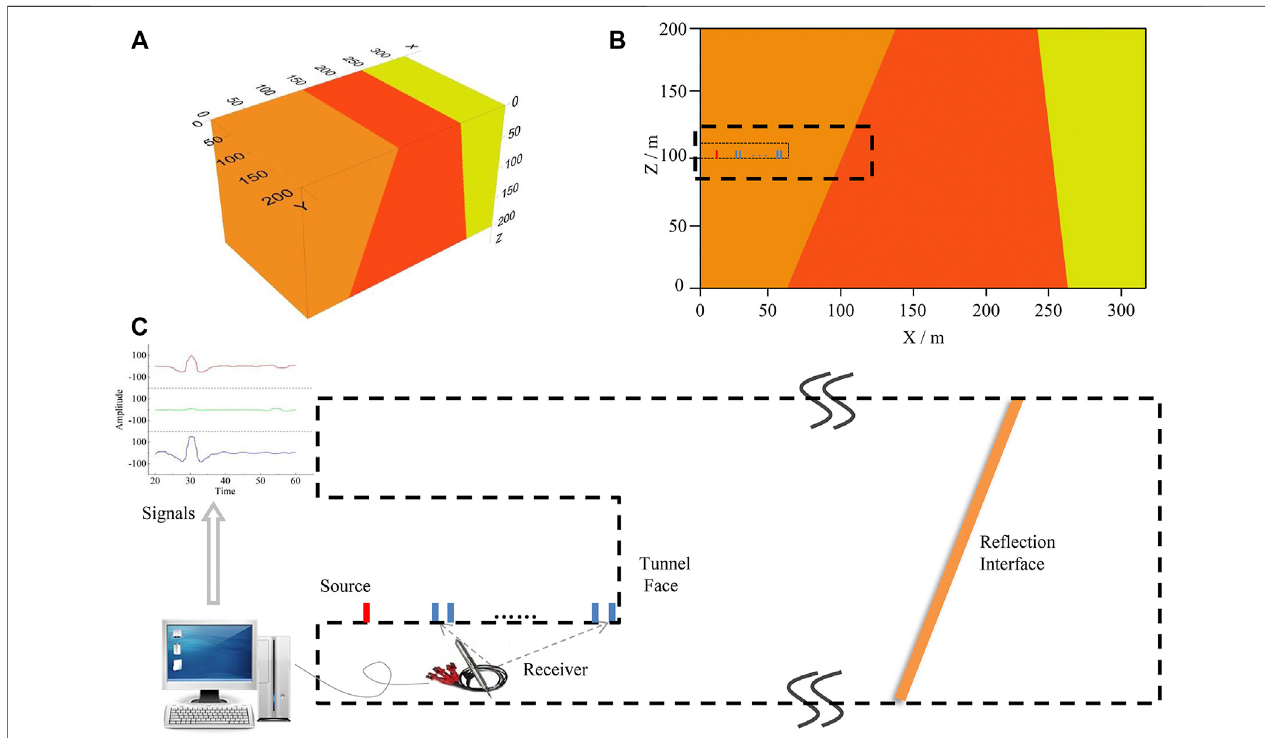
FIGURE4| Geologicalmodelandseismicobservationsystem. (A) 3Dgeologicalmodel; (B) XOZdiagrammaticcross-section; (C) Thepartiallyenlargedschematic diagram of observation system.